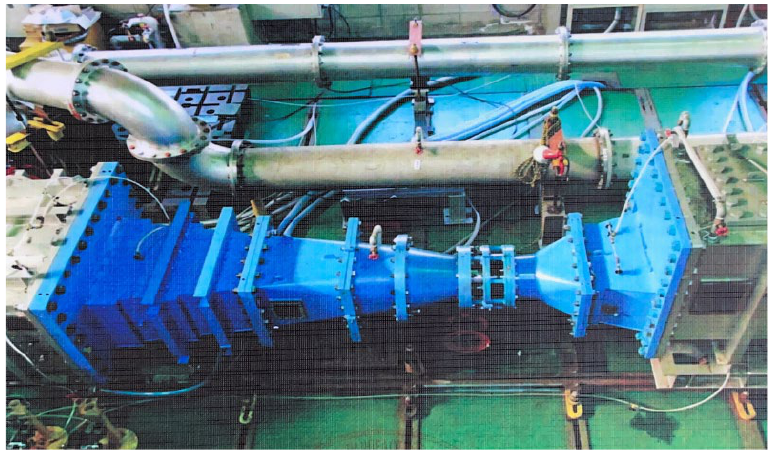
Figure 6. Experimental setup.